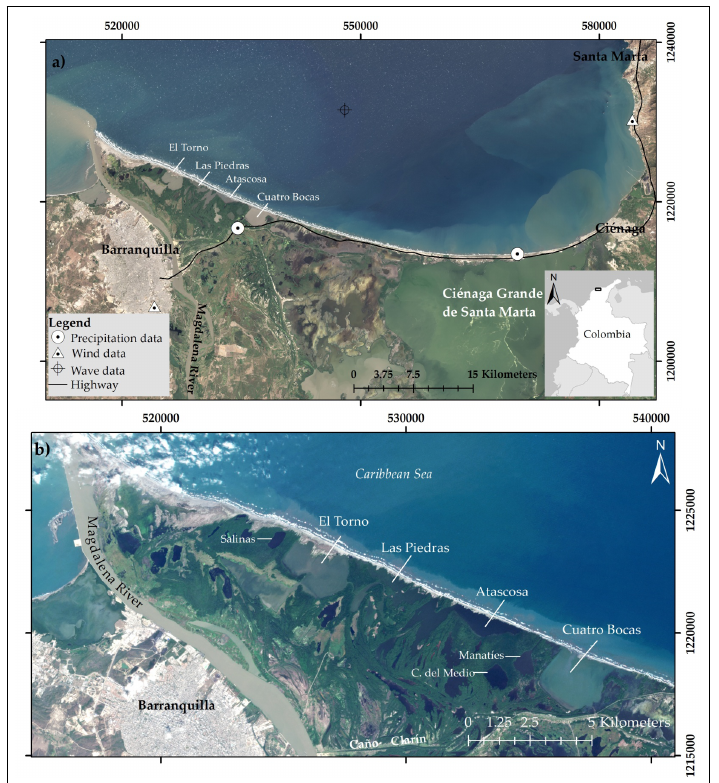
Figure 1. Map of the Magdalena River delta and its marginal lagoons on the northeast coast of Colombia. ( a ) The coastline between the cities of Santa Marta and Barranquilla and the measuring stations are shown. ( b ) Zoom of lagoons that are the focus of this work, including from east to west: Cuatro Bocas, Atascosa, Las Piedras, and El Torno lagoons. The Magdalena River, the largest fluvial system in Colombia, is connected to these lagoons via a network of natural channels. The mouth of the river is situated in a